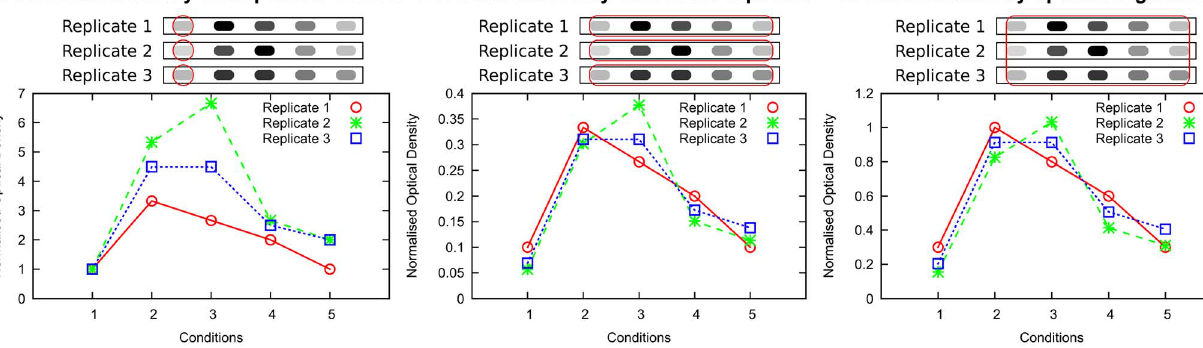
Figure 1. Normalisations of Western blot replicates in the literature. We divide the normalisations found in literature into three categories: (A) normalisation by fixed normalisation point or control; (B) normalisation by sum of the replicate; (C) normalisation by optimal alignment. For illustration purposes we do not use actual Western blot data. Each normalisation is presented using three cartoon Western blots, representing three replicates, and highlighting with red circles the data points used in the normalisation procedure. The graphs show the normalised data, where the points belonging to the same replicate are connected with lines.